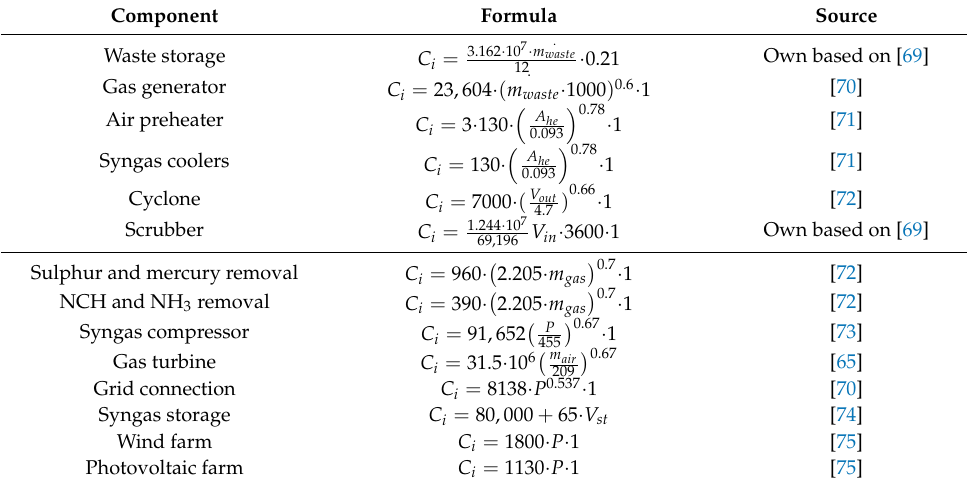
Table 4. Investment cost